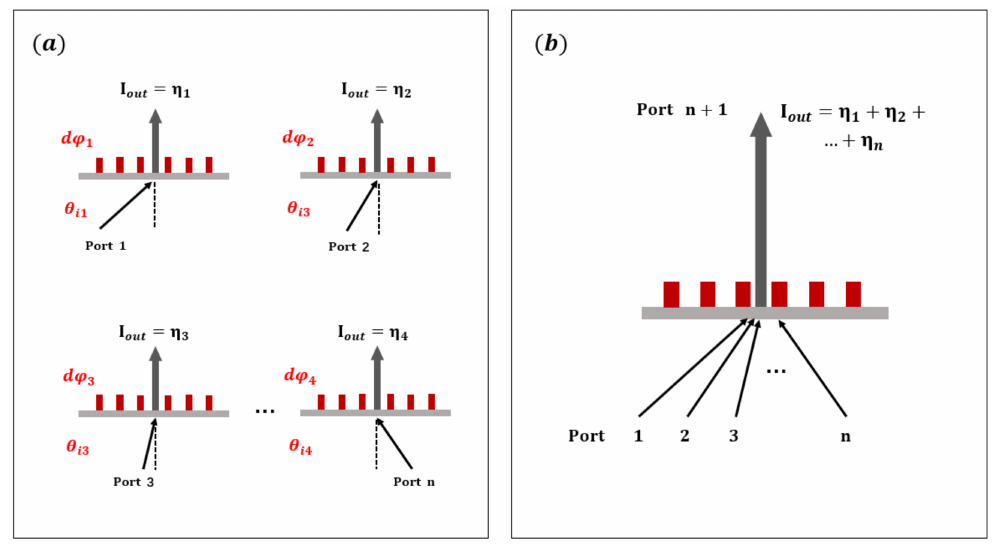
Figure 2. Schematic of the metasurface beam combiner. ( a ) Working in single-port mode; ( b ) Working in multi-port